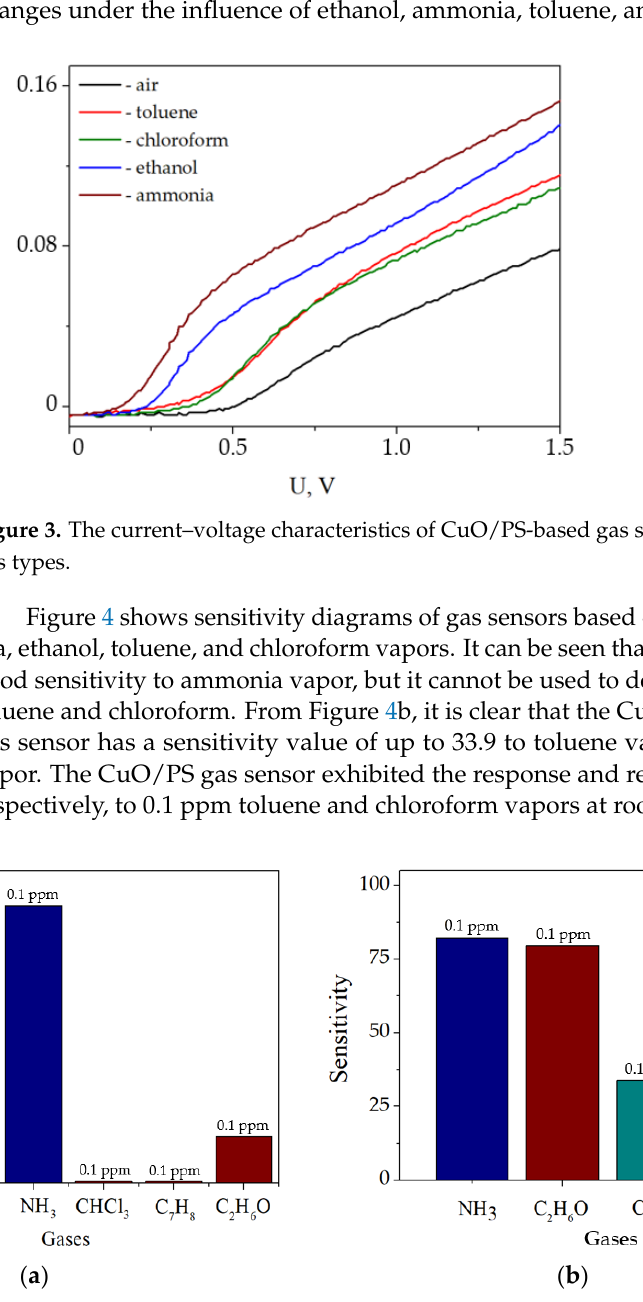
Figure 4. Sensitivity diagrams of gas sensors based on PS ( a ) and CuO/PS ( b ) to different gas types.